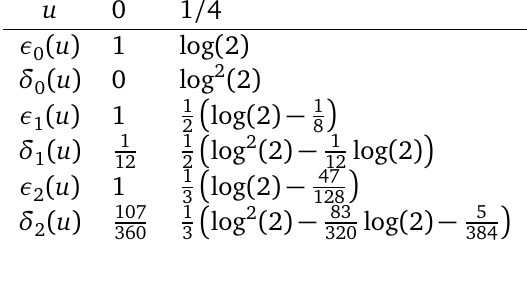
( u ) and δ ( u ) appearing in (77) in the limits of the n n